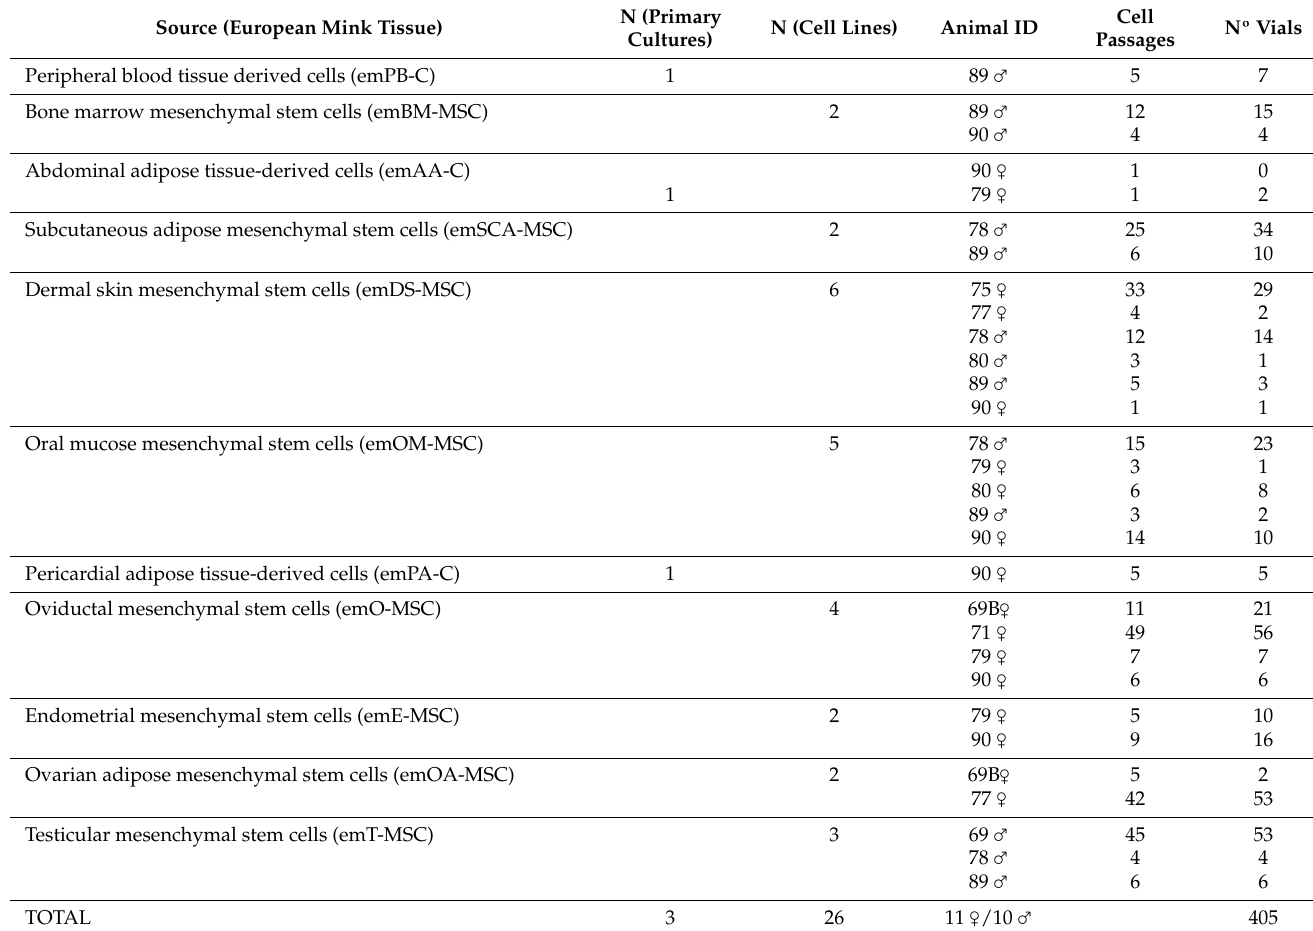
Table 1. European mink primary cultures and cell lines biobank content. Summary of primary cultures and established cell lines preserved in the biobank, organized by source, animal gender, number of passages, and number of